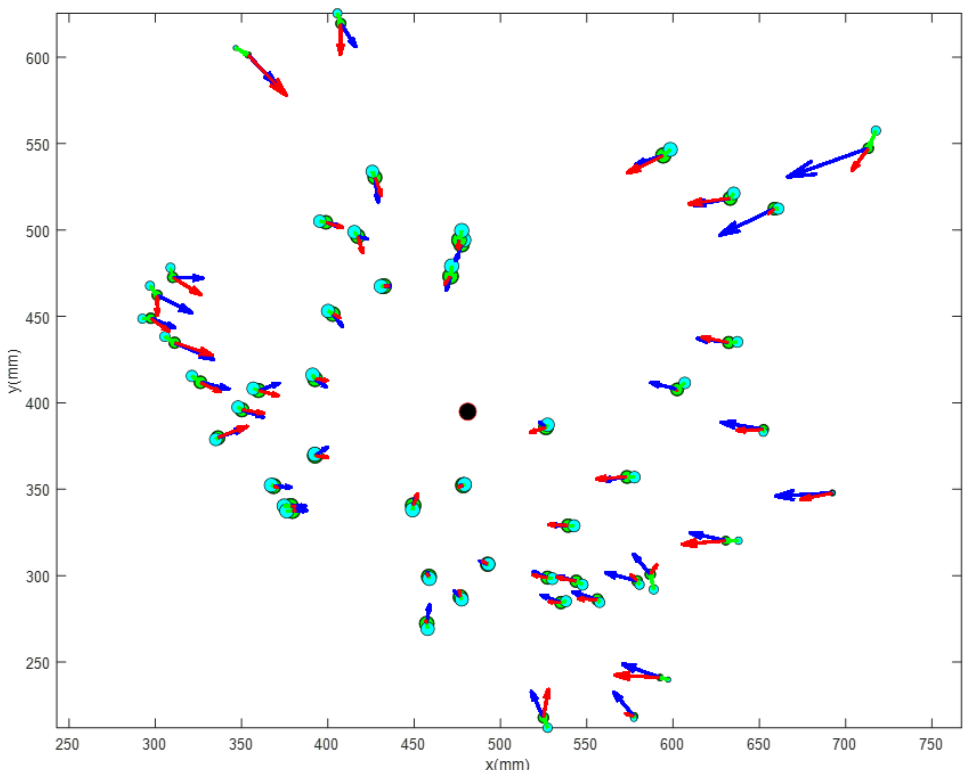
Figure 6. Comparison of the directions computed by the two algorithms during the iterative process.